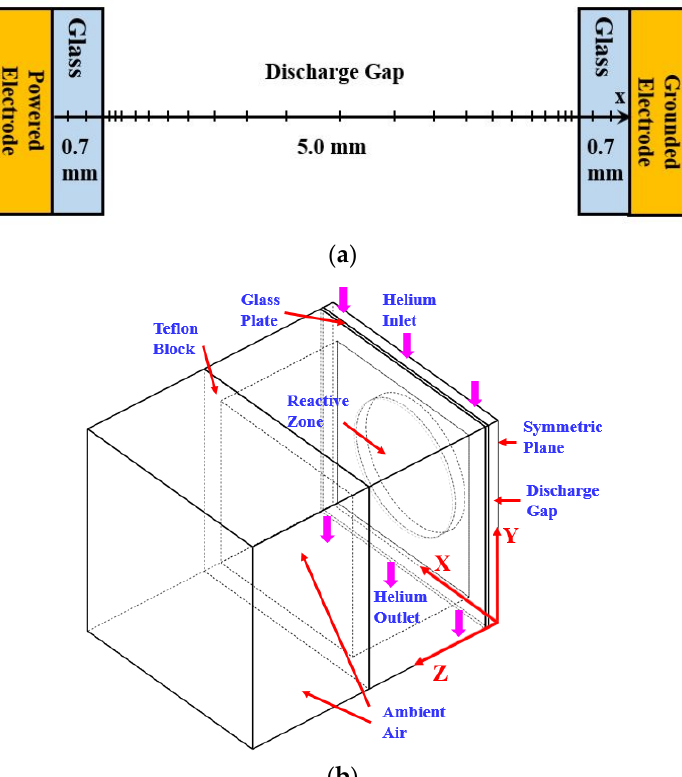
Figure 2. The numerical domains: ( a ) 1D PFM; ( b ) three-dimensional gas flow model (3D GFM).